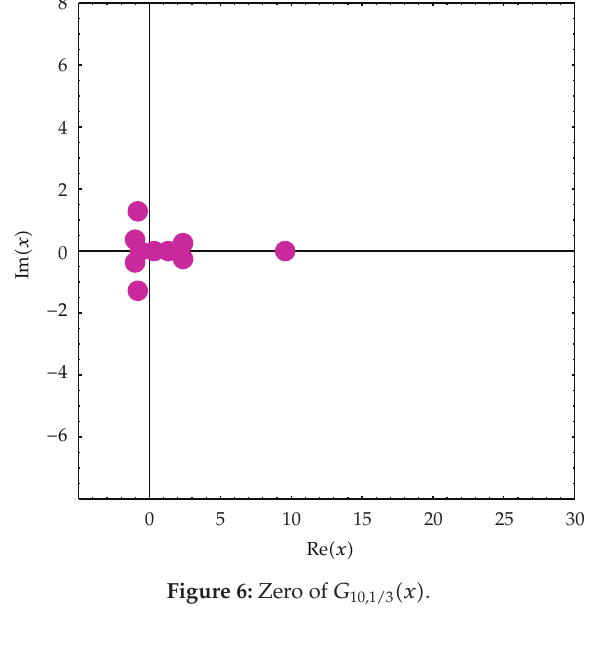
Figure 6: Zero of G 10 , 1 / 3 (cid:2) x (cid:3) .